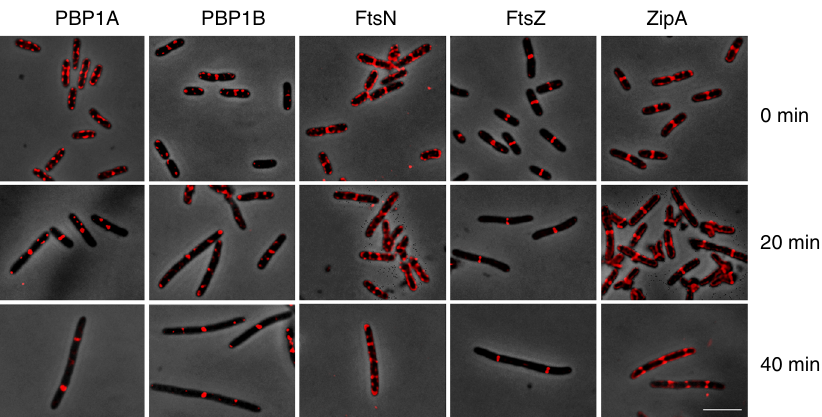
Fig. 2 PBP1A, PBP1B, FtsN, FtsZ and ZipA localise at potential cell division sites in the presence of aztreonam. Merged micrographs of phase contrast and immunolocalisation images of PBP1A, PBP1B, FtsN, FtsZ or ZipA, detected with puri fi ed antibodies, in BW25113 cells grown in the absence or presence of 0.3 μ g mL − 1 aztreonam (for 20 or 40 min). Scale bar represents 5 μ (Fig. 2). FtsA and FtsZ-rings localised at preseptal sites in ZipA- depleted cells as expected (Supplementary Fig. 5) 14 . These data suggest that ZipA is required for the correct localisation of PBP1A and PBP1B at preseptal positions.